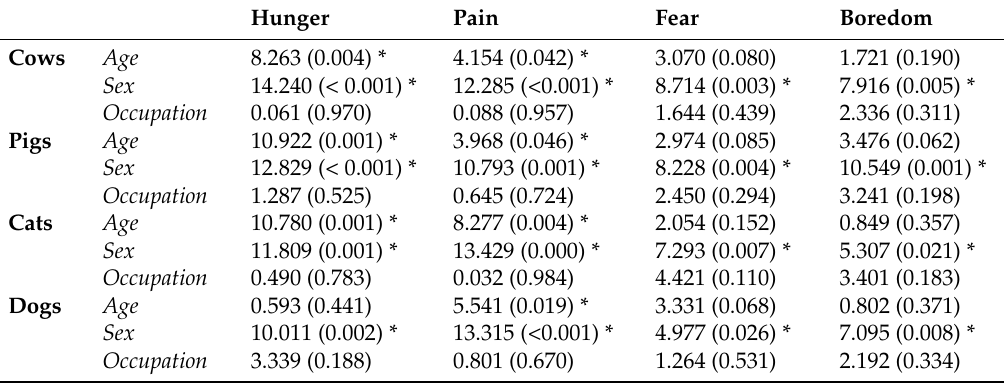
Table 2. The Logistic Regression Chi-Square test χ 2 ( p -values) for the participants’ ( n = 41) demographics and their response regarding beliefs about the sentience of animals by species and